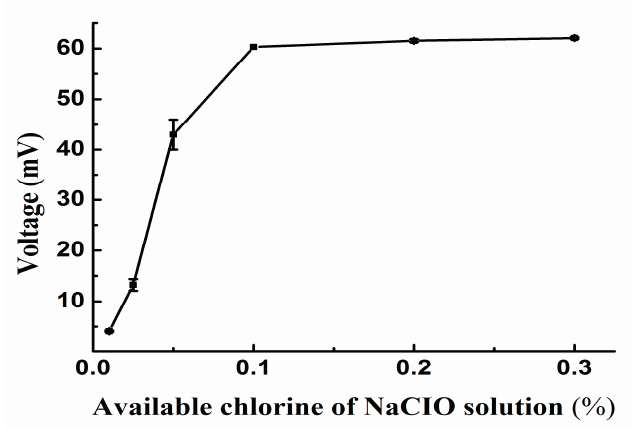
Figure 3. Peak voltage from the reaction of glycine with different NaClO concentrations (Other conditions are as in Figure